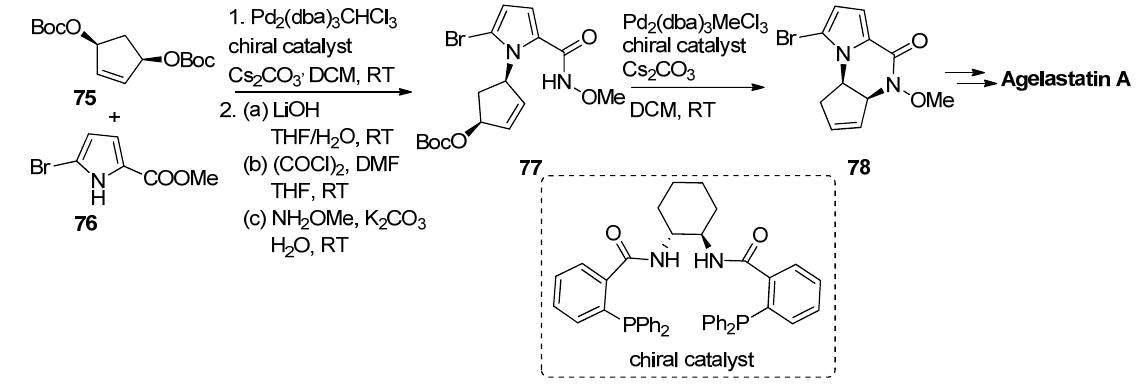
Scheme 21. Palladium-catalyzed intramolecular allylation strategy toward